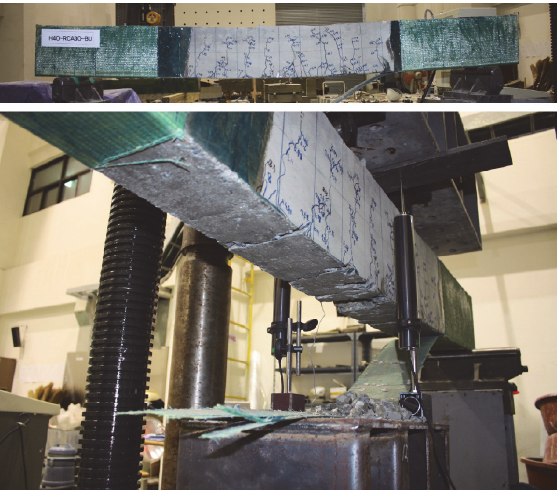
Figure 12: Load-displacement